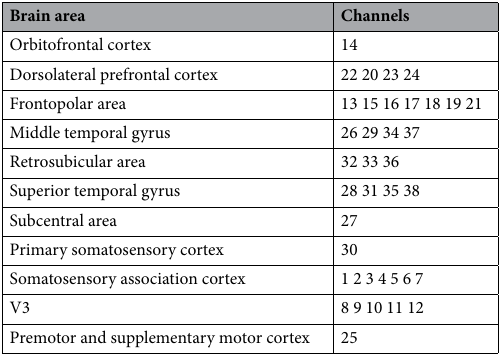
Table 2. fNIRS channels and related brain areas (estimates are based on a neuro-navigational measurement of an exemplary volunteer).